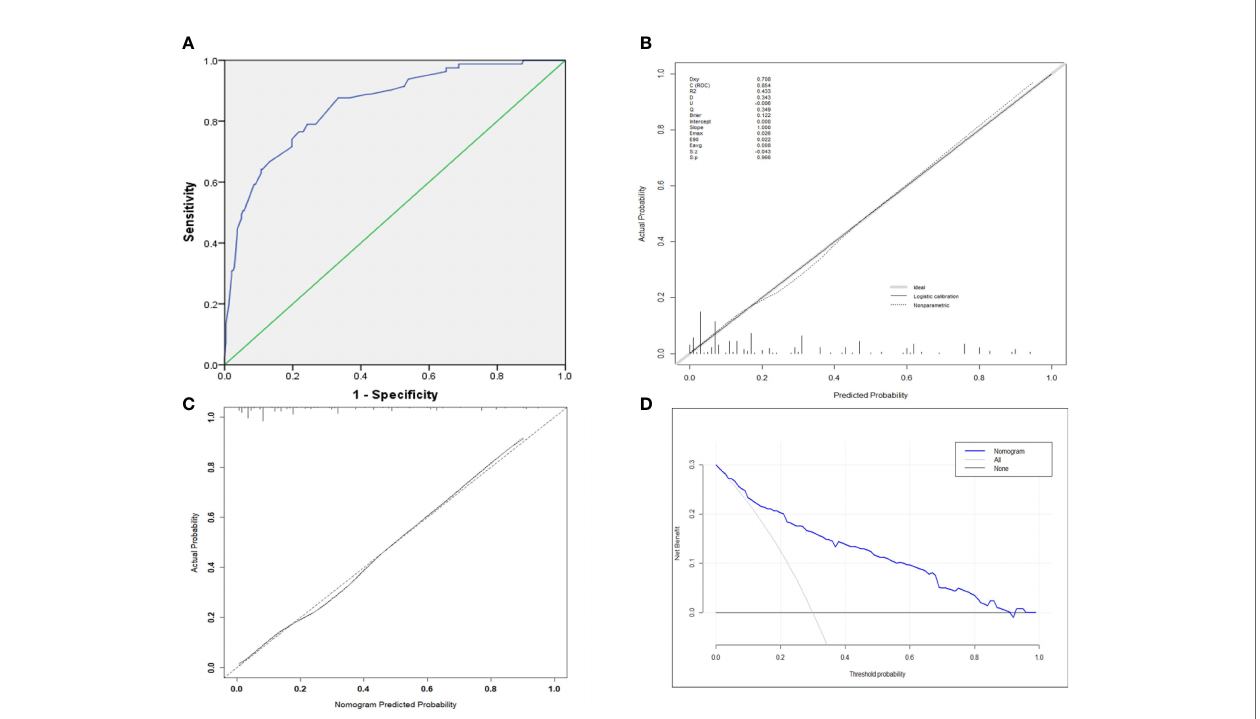
FIGURE 3 | (A) ROC curve for the prediction nomogram. (B) The Brier score for the prediction nomogram. (C) Calibration curve showing nomogram-predicted EF probabilities compared with the actual EF. (D) The decision curve analysis of the